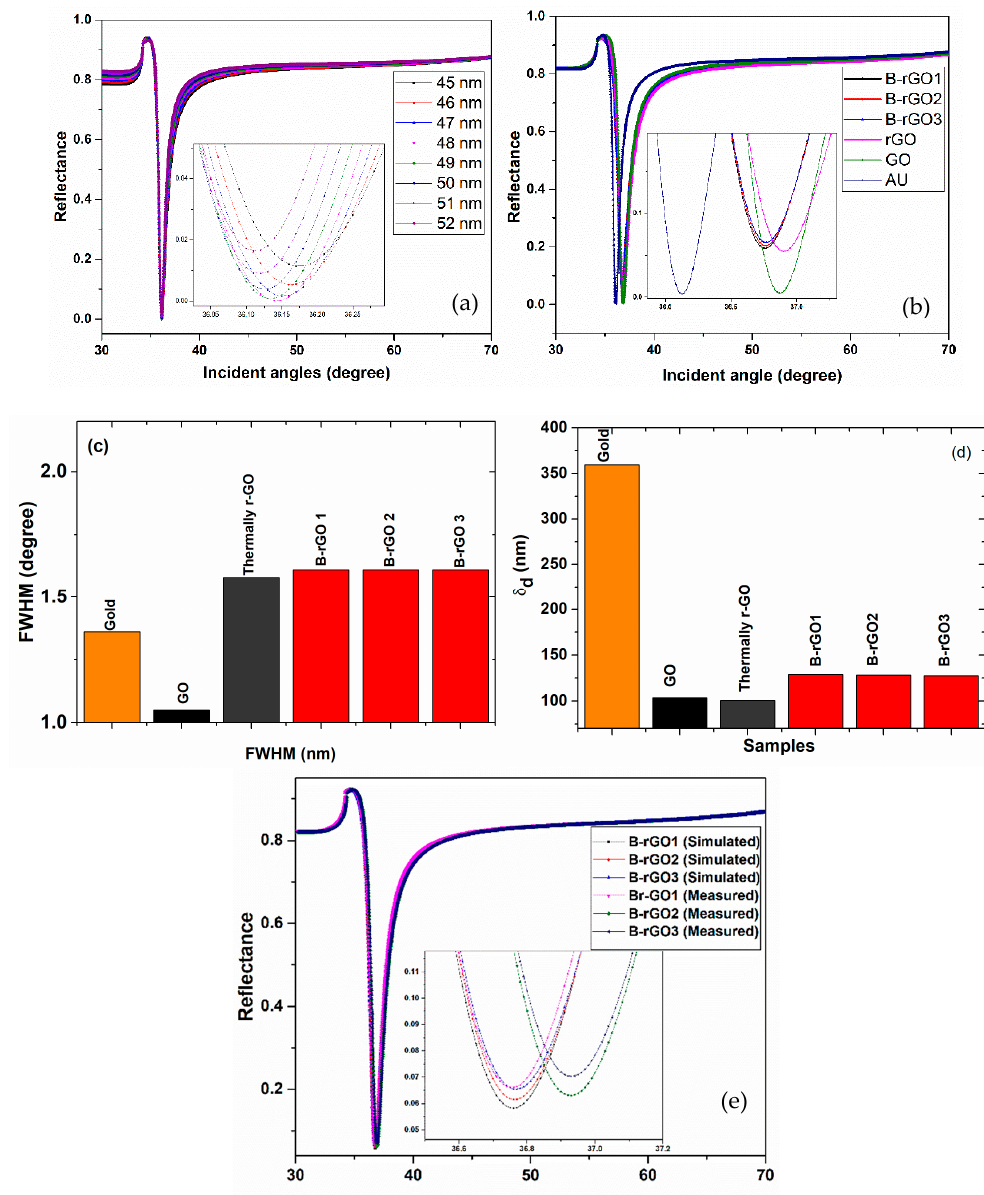
Figure 6. ( a ) SPR curves for the optimization of gold film thickness. ( b ) SPR curves for gold, GO, thermally reduced GO, B-rGO1, B-rGO2, and B-rGO3-based SPR sensors. ( c ) Variations of FWHM for gold, GO, thermally reduced GO, B-rGO1, B-rGO2, and B-rGO3 based SPR sensors ( d ) Variations of dielectric penetration depth in for gold, GO, thermally reduced GO, B-rGO1, B-rGO2 and B-rGO3-based SPR sensors. ( e ) Comparative study of the simulated and measured SPR response for B-rGO1, B-rGO2, and B-rGO3-based sensors.